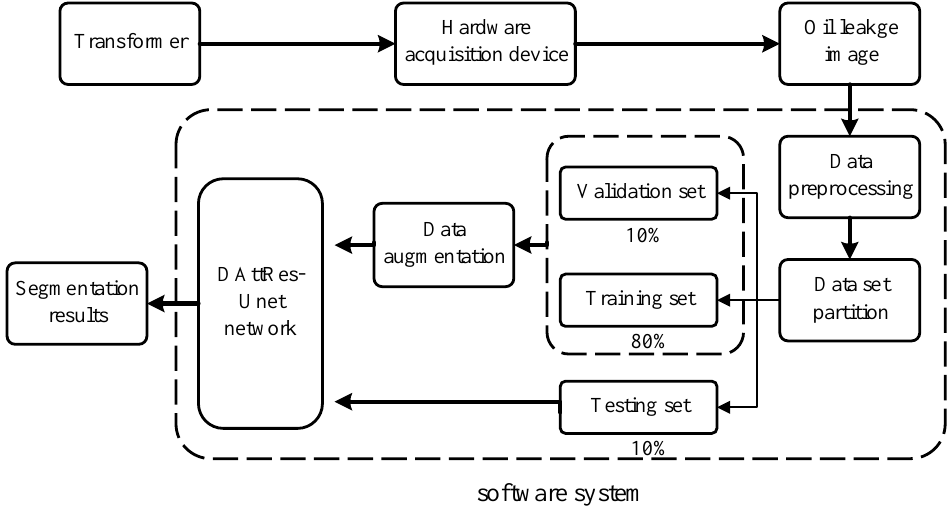
Figure 2. Procedure of detecting leaked oil from a transformer through fluorescent